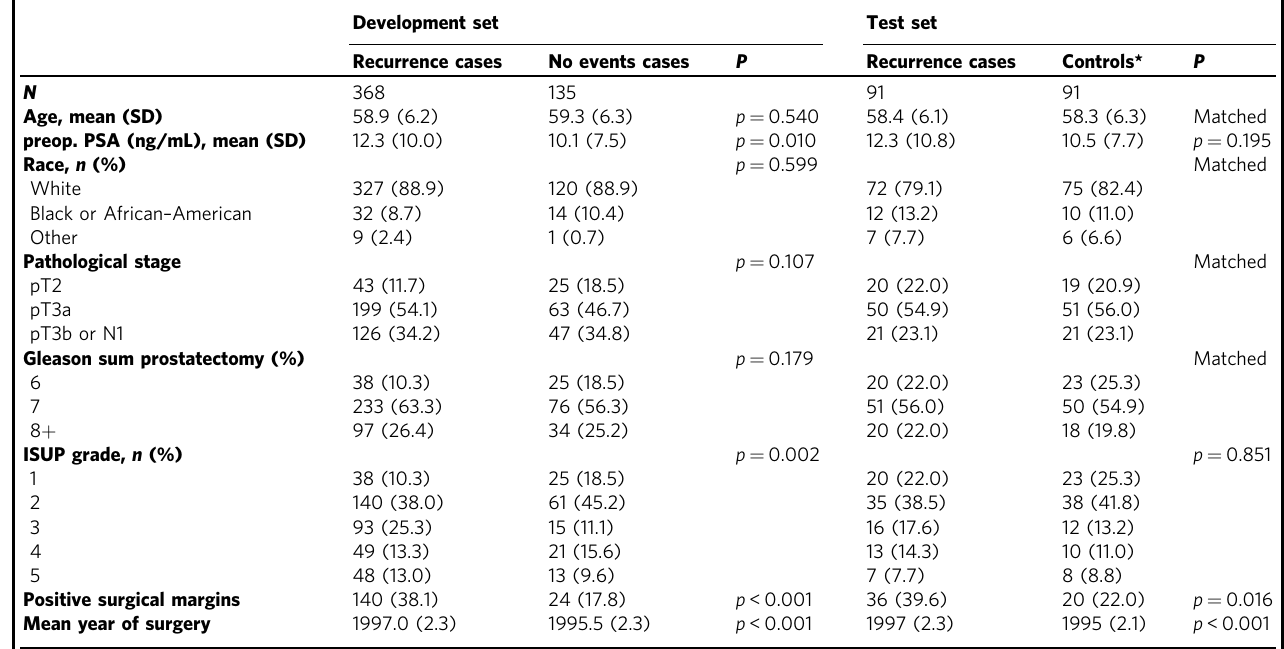
Table 1 Baseline characteristics of test set and development set from the John Hopkins Hospital, prostate cancer recurrence cases and controls, men who underwent radical prostatectomy for clinically localized disease between 1993 and